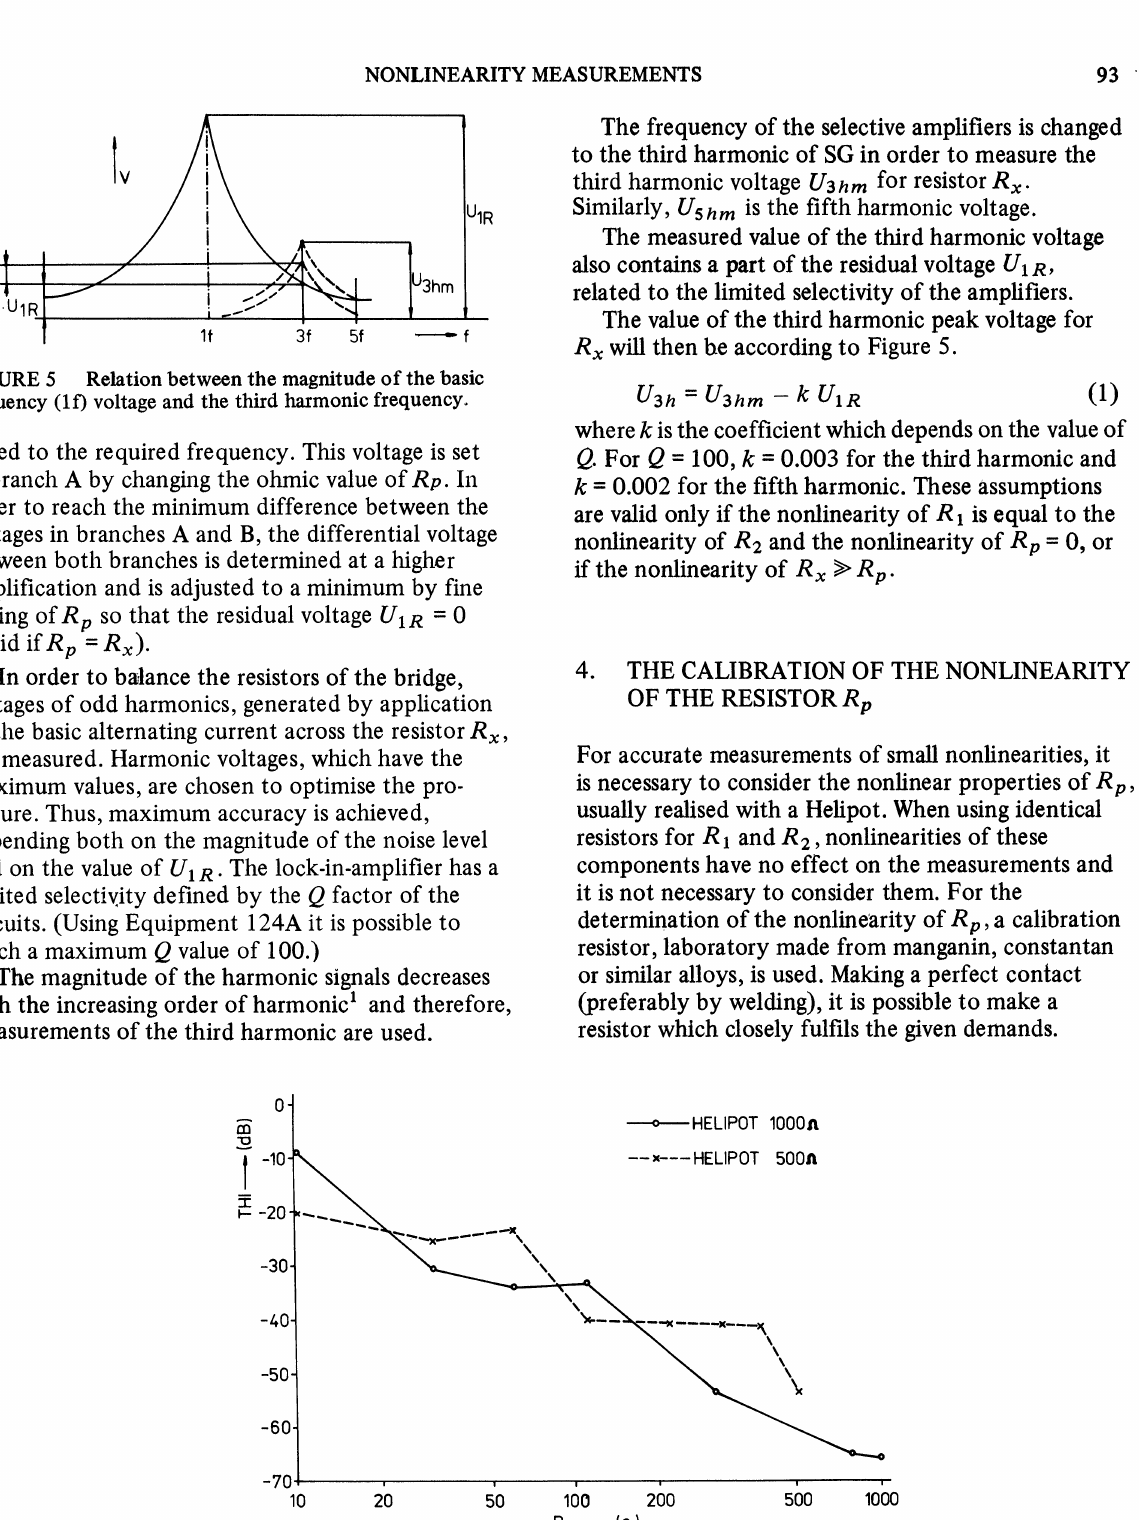
Dependence of THI on the value R p for